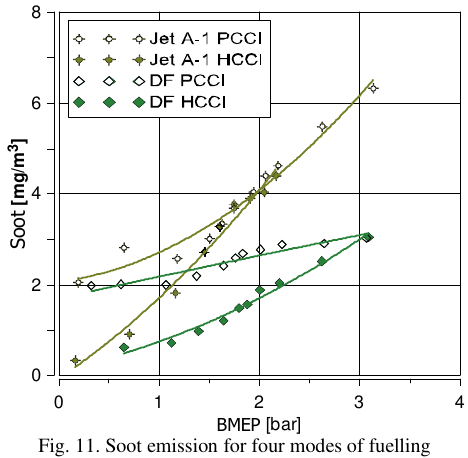
Fig. 11. Soot emission for four modes of fuelling